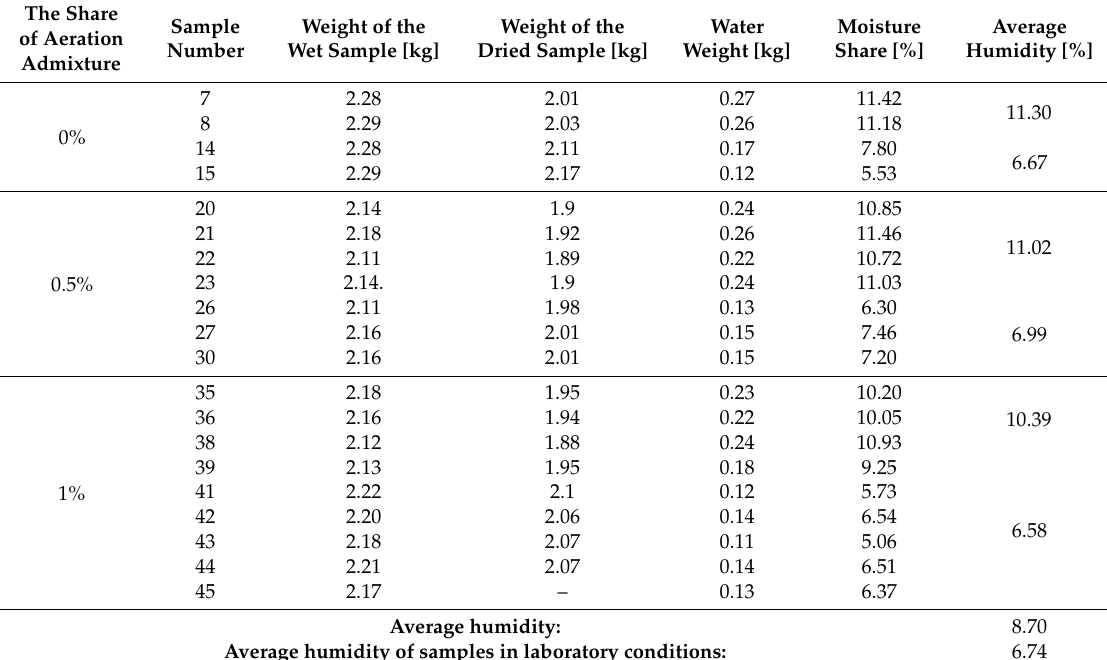
Table 2. Moisture samples subjected to